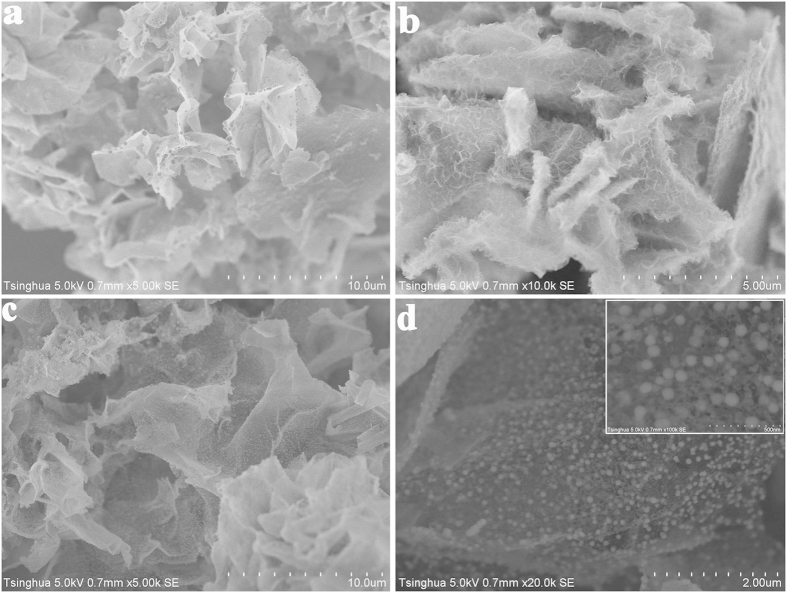
FESEM images of the Co3O4 nanohybrids with different magnifications.